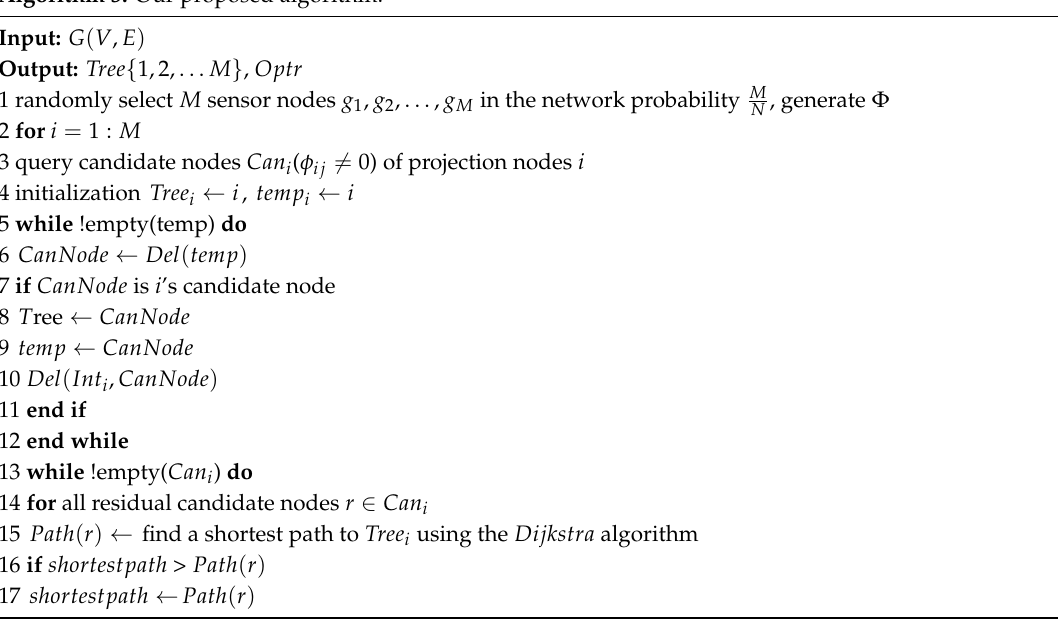
Algorithm 3. Our proposed